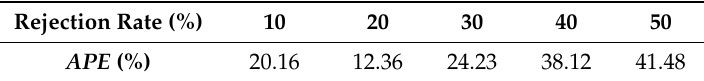
Table 1. E ff ect of the rejection